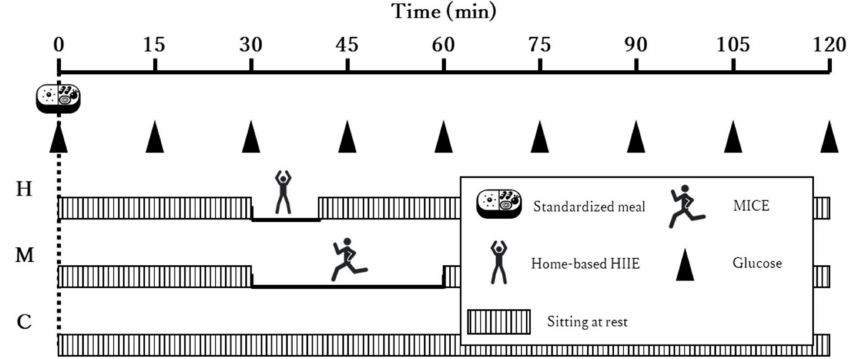
Figure 1. A summary of the experimental trials. Participants started eating the standardized meal at 0 min. After 30 min of sitting at rest, participants performed 11 min of home-based HIIE in the H condition, and 30 min of MICE in the M condition. The participants sat at rest until 120 min after the start of eating the standardized meal. In the C condition, the participants sat at rest for the entire 120 min. Glucose concentrations were automatically measured every 15